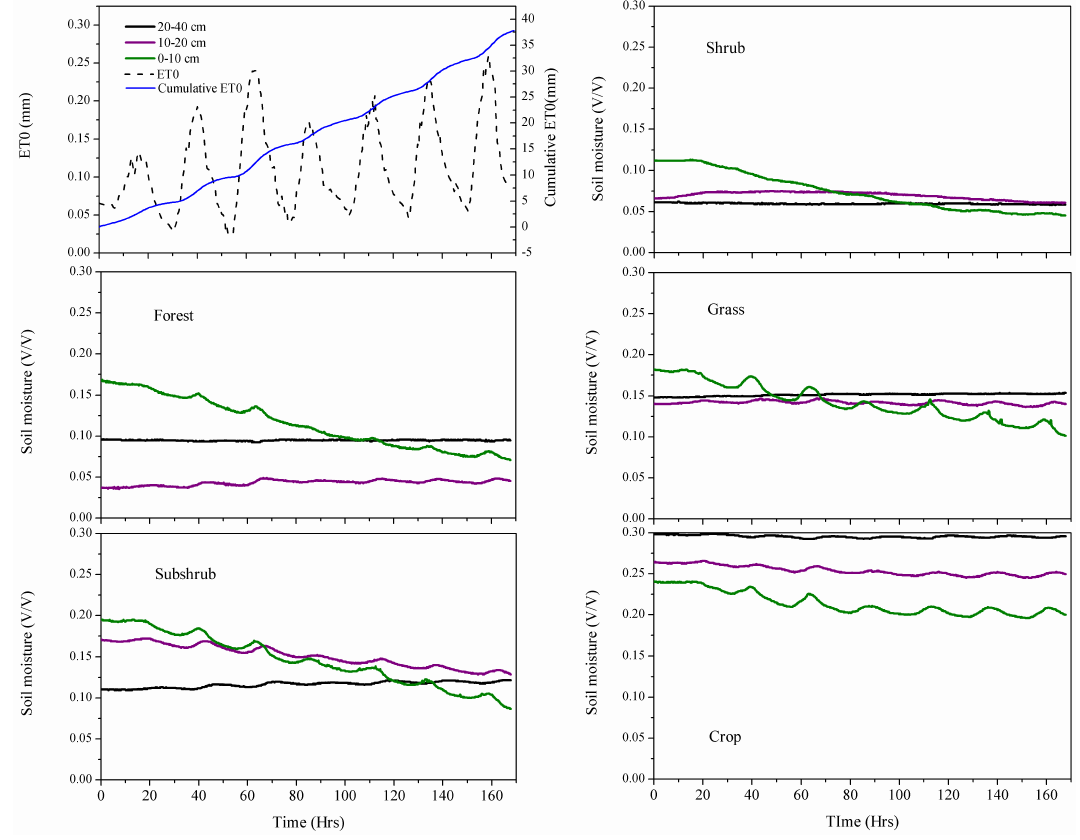
Fig. 4. Soil moisture decrease process under the five land cover types from 6 July to 12 July.